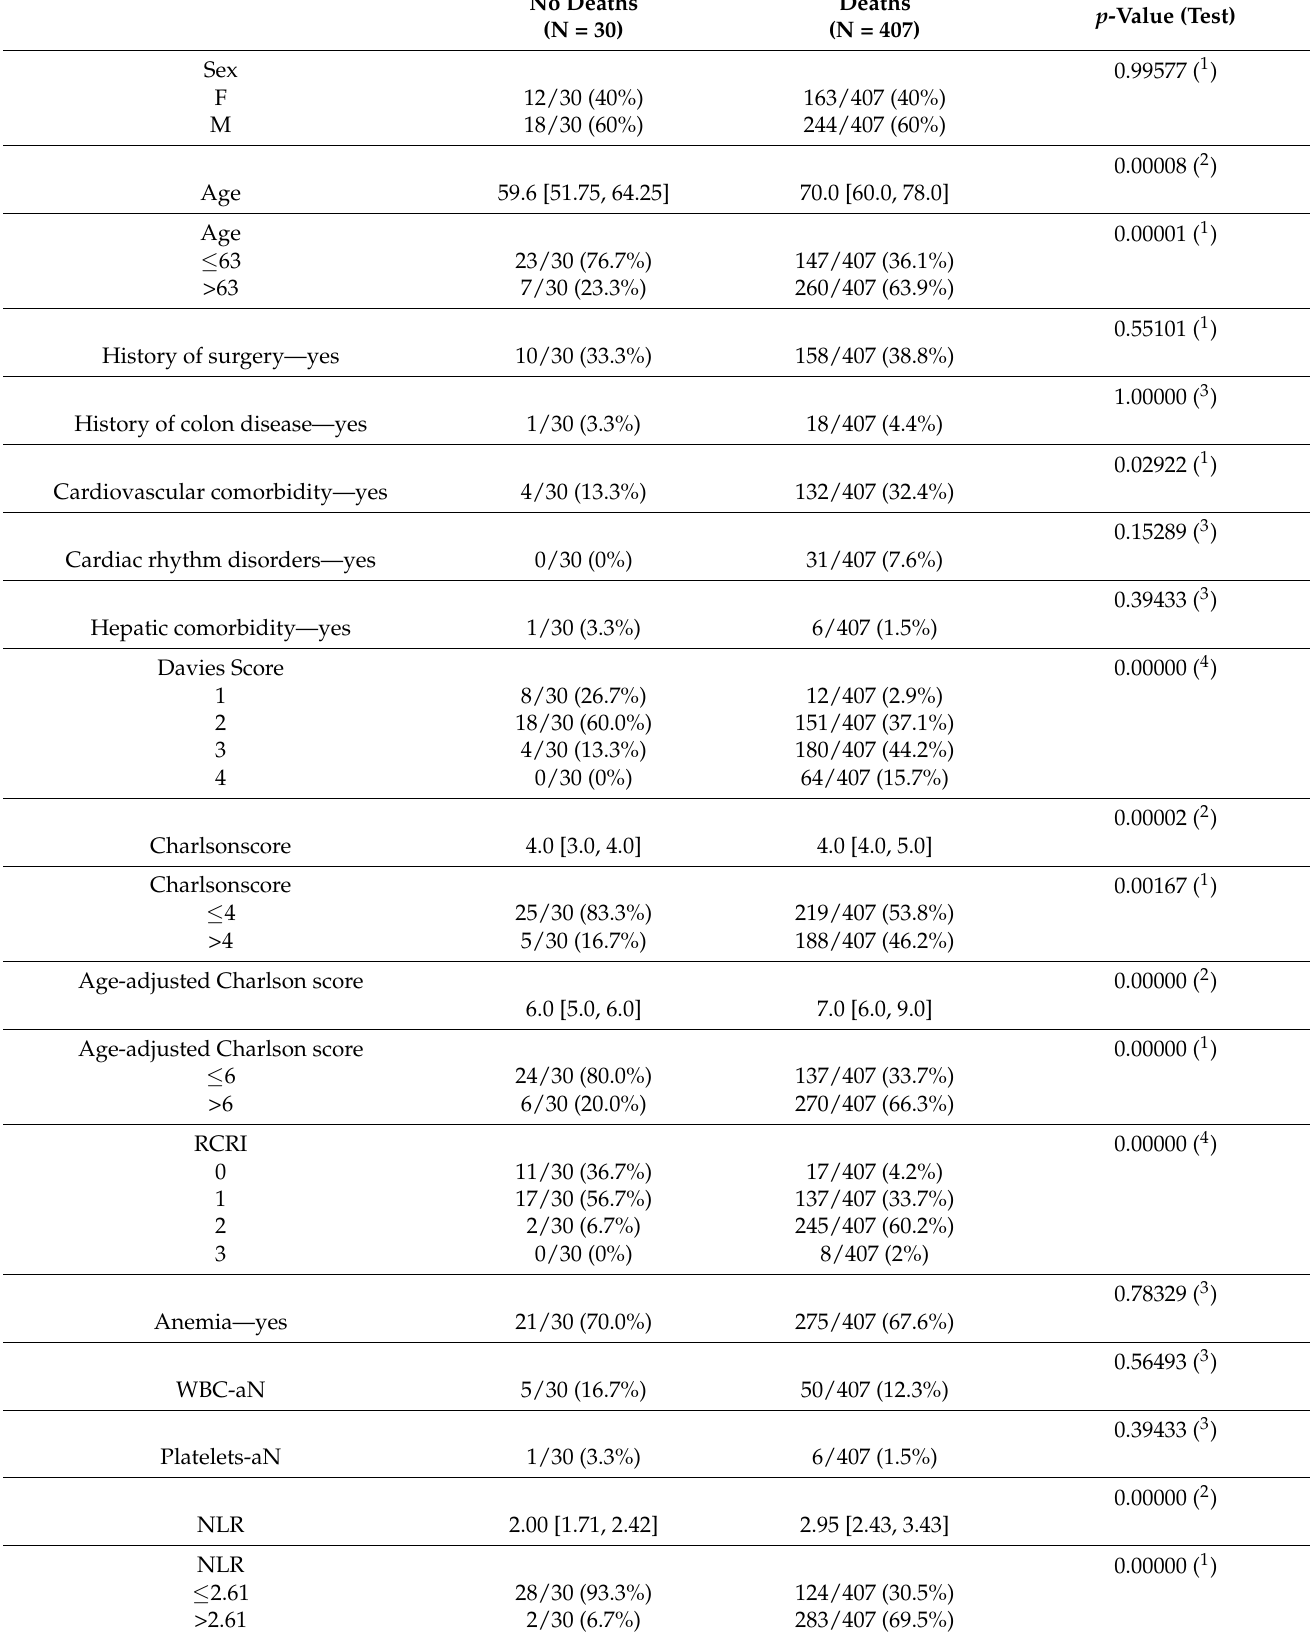
Table 1. Descriptive data and statistical association with overall